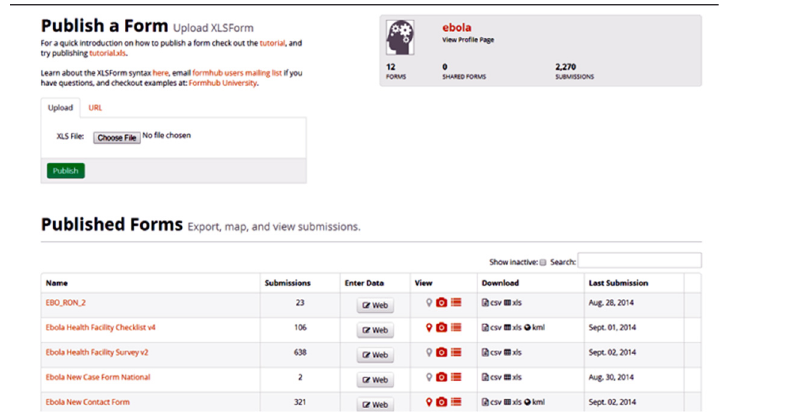
Fig 2. Screen shot of Form Hub